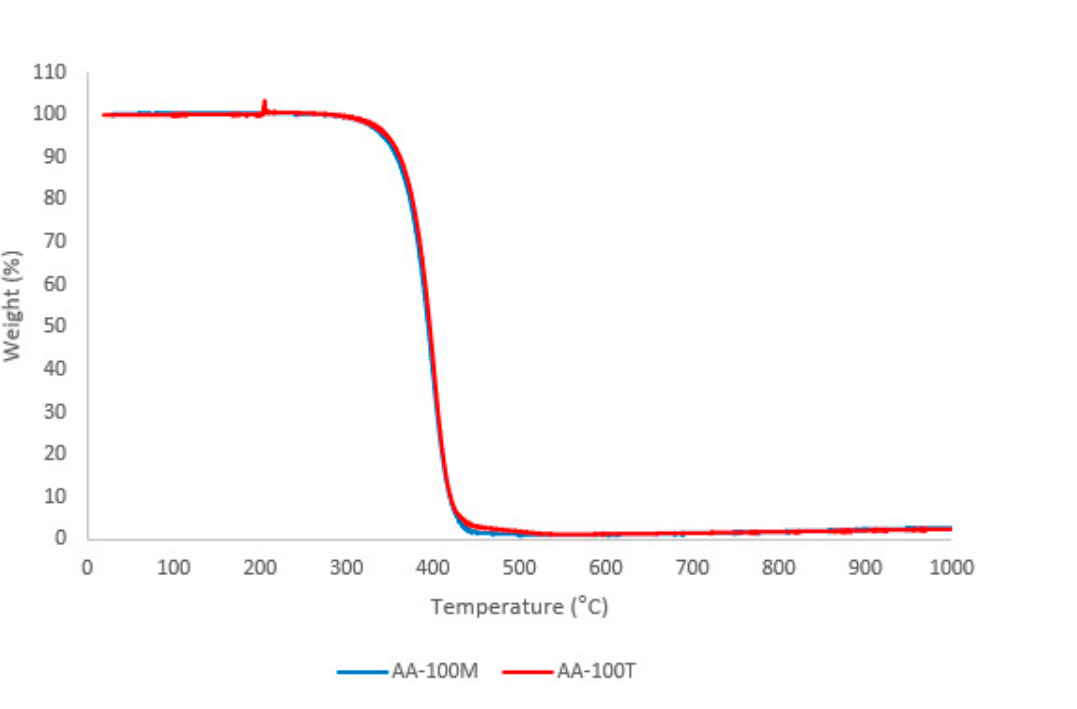
Table 5. TGA results for AA-100M; AA-75T-25; AA-50T-50M; AA-25T-75M;